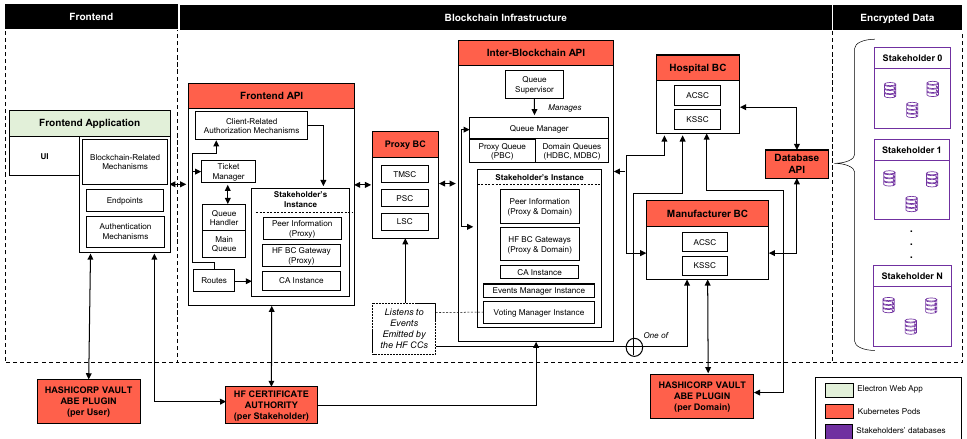
Figure 5. Janus implementation design based on the HMBAC